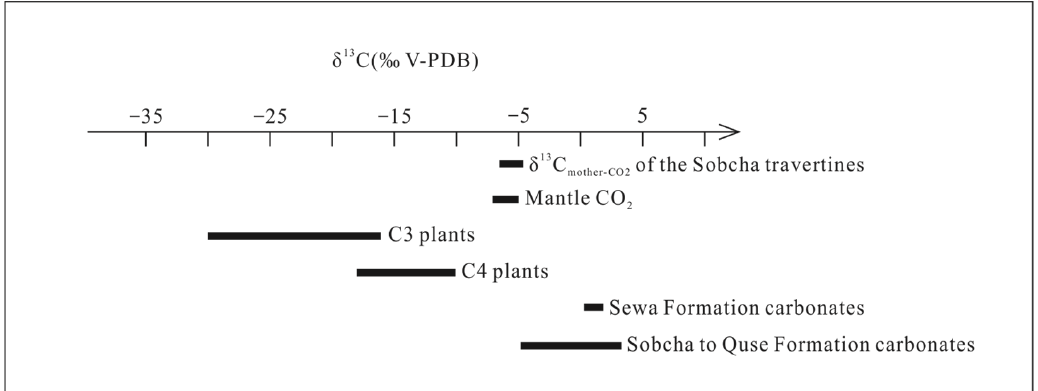
Figure 7. Calculated δ 13 C mother-CO2 of the Sobcha travertines in comparison with δ 13 C of potential carbon sources. δ 13 C ranges of mantle-derived CO 2 and CO 2 related to C3 plants and C4 plants were from Vogel [69] and Prokoph et al. [68]. δ 13 C ranges of carbonate rocks of the Sewa Formation and